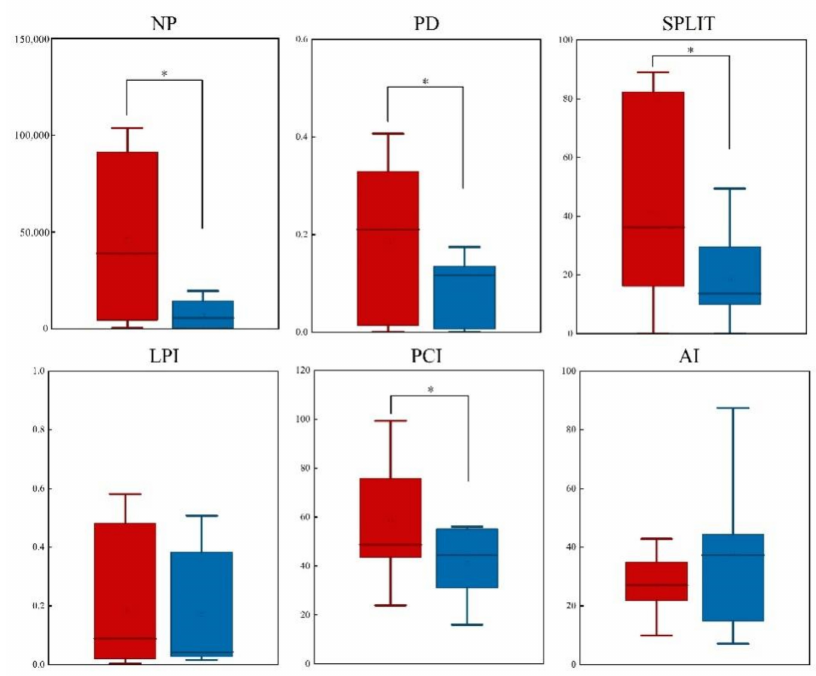
Figure 4. Comparison of potentially suitable habitats of nature reserves (blue) and non-nature (red) reserves of C. Pictus. Note: NP: Number of patches; PD: Patch density; SPLIT: Slitting index; LPI: Largest patch index; PCI: Patch cohesion index; AI: Aggregation index. *: p < 0.05.